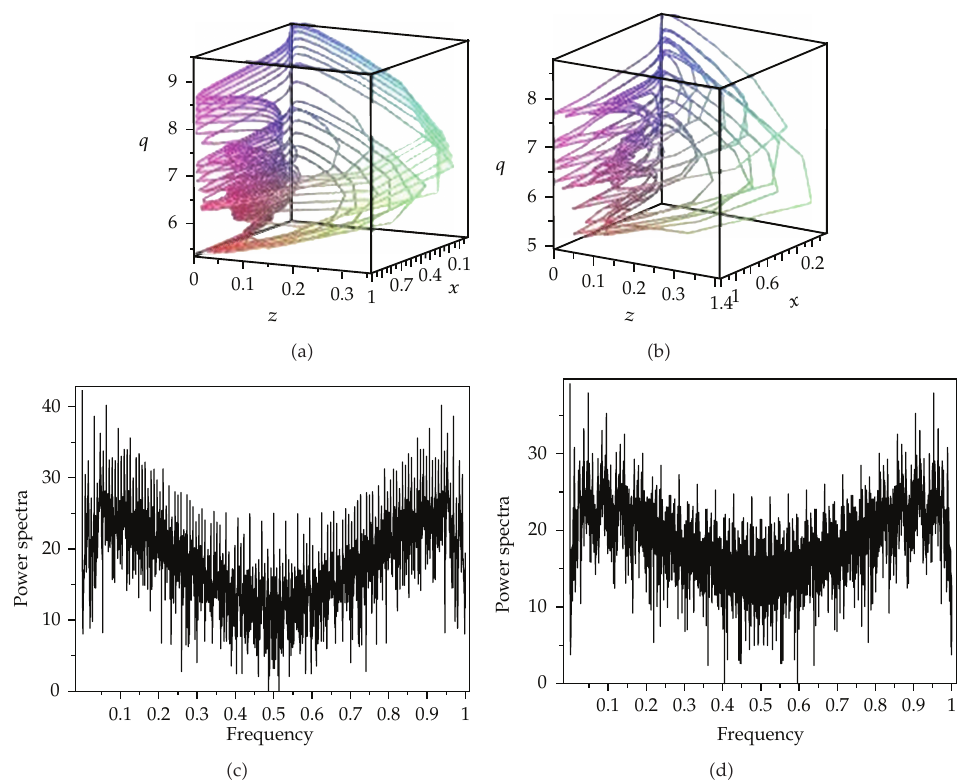
Figure 10: Strange attractors and power spectra: (cid:2) a (cid:3) strange attractor when T (cid:7) 32, (cid:2) b (cid:3) strange attractor when T (cid:7) 21, (cid:2) c (cid:3) power spectrum of attractor (cid:2) a (cid:3) , and (cid:2) d (cid:3) power spectrum of attractor (cid:2) b (cid:3)